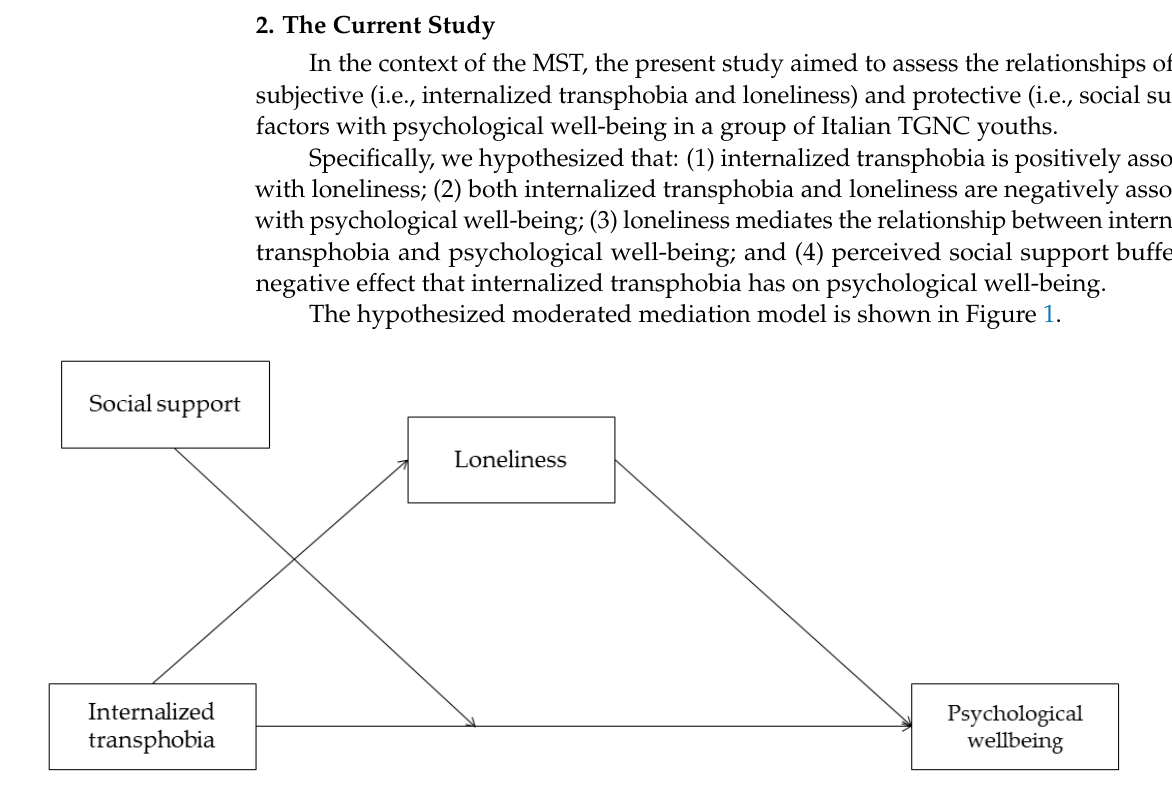
Figure 1. The hypothesized moderated mediation model.